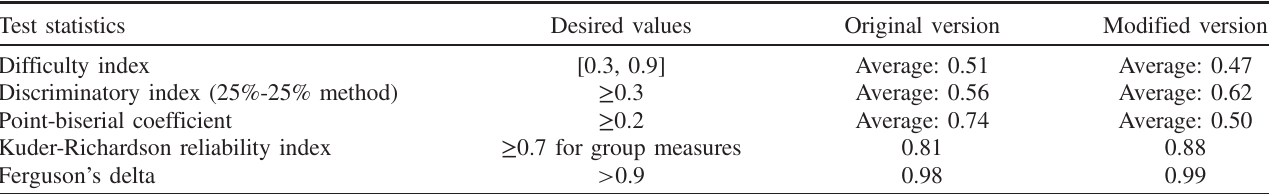
TABLE XII. Summary of the results of the five statistical tests suggested by Ding et al. [17] for the original and modified versions of the